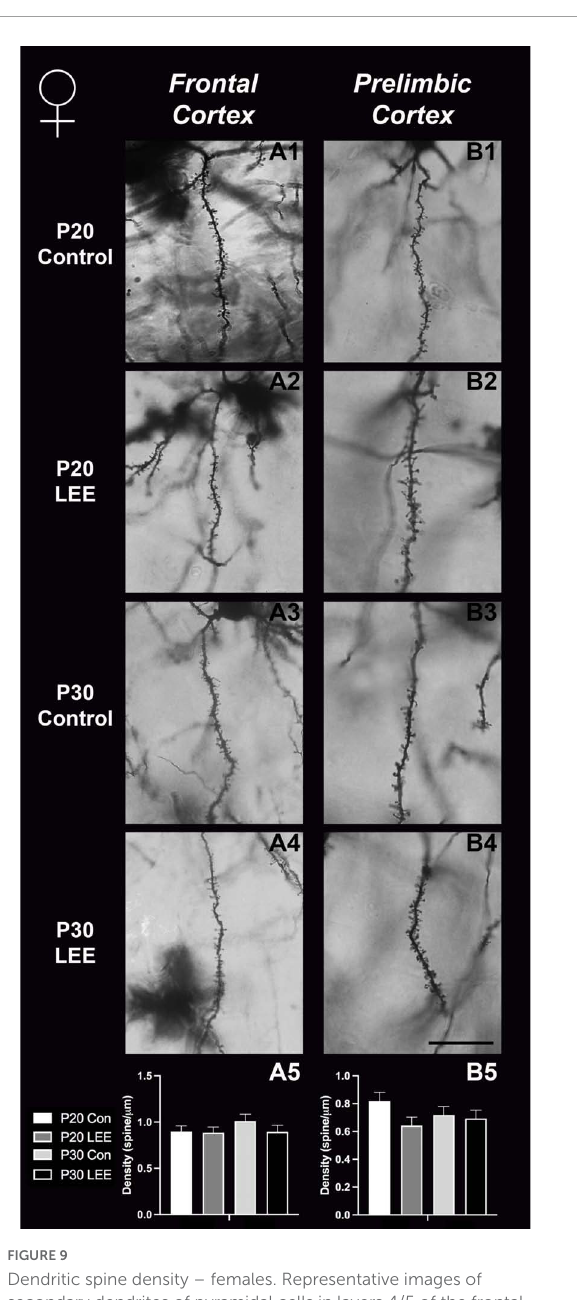
FIGURE9 Dendritic spine density – females. Representative images of secondary dendrites of pyramidal cells in layers 4/5 of the frontal and prelimbic cortices of female control (A1,B1,A3,B3) and LEE (A2,B2,A4,B4) pups at P20 and P30. Comparison of dendritic spine density of males indicated no significant differences in frontal ( A5 ; N = 16) and prelimbic ( B5 ; N = 16) cortices. Data expressed as mean ± SEM. Scale bar, 250 µ m.